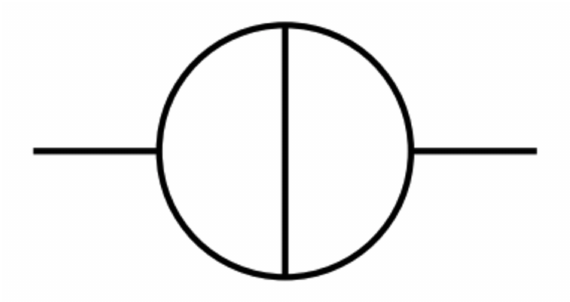
Figure 4 . Sub-subleading order:B.